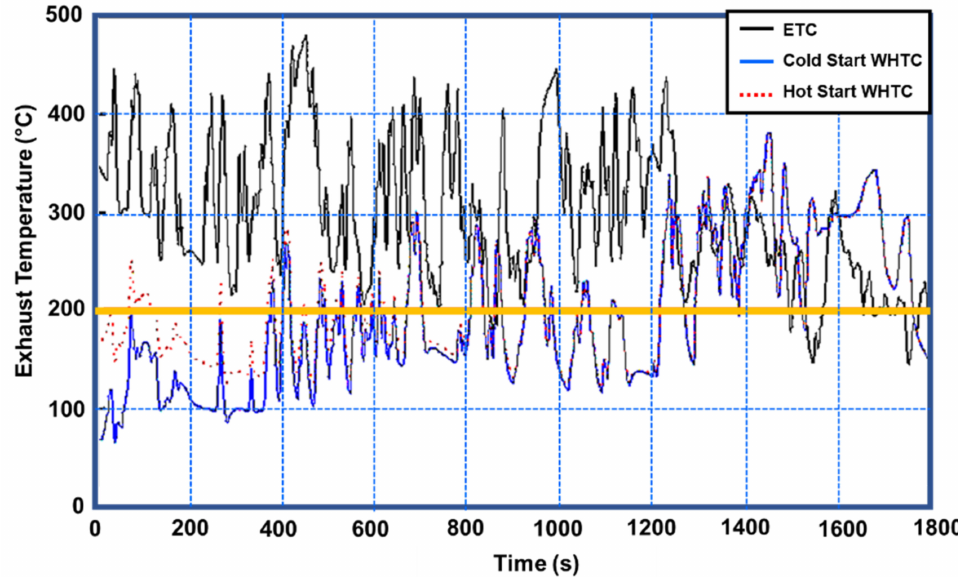
Figure 27. Comparison of exhaust temperatures for the ETC and WHTC, adapted from Bai et al. [114].